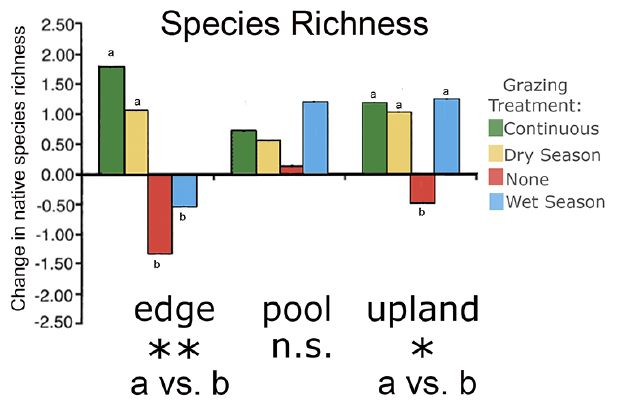
Fig. 3 . Grazing increased species richness in vernal pools in California annual grasslands. Change in native species richness (s) per quadrat between 2001–2003 in four grazing treatments: continuously grazed, dry season grazed, wet season grazed, and